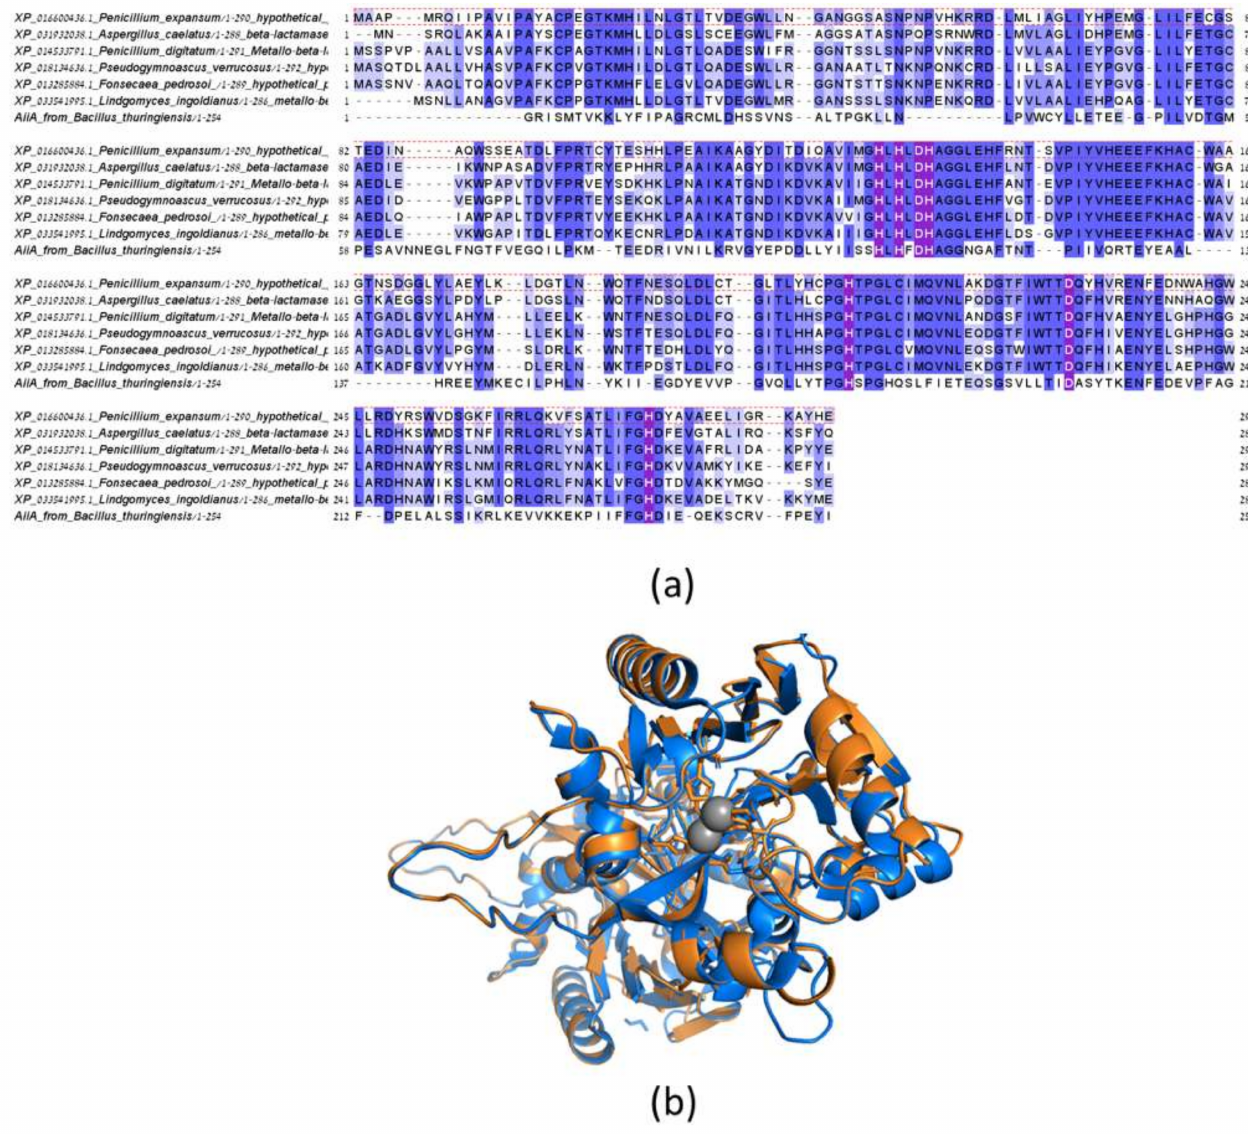
Figure 3. The identification of putative lactonases in various fungal species based on sequence homology and structural modeling of P. expansum homolog . ( a ) Multiple-sequence alignment of newly identified putative fungal lactonases. The color intensity correlates with the percentage identity. The HxHxDH~H~D~H motif is common to all AHL lactonases in the MBL (Metallo- β -lactamase) superfamily. The first sequence is of the homolog from P. expansum . The residues that coordinate the two catalytic metals are highlighted in dark purple. ( b ) Shown are the backbones of the structural homology models of the putative lactonase from P. expansum, PELa (orange) and AHL lactonase from Alicyclobacillus acidoterrestris (pdb 36cgy) (blue), and the active-site zinc atoms (gray). The catalytic residues of both enzymes are presented as sticks in the binuclear catalytic